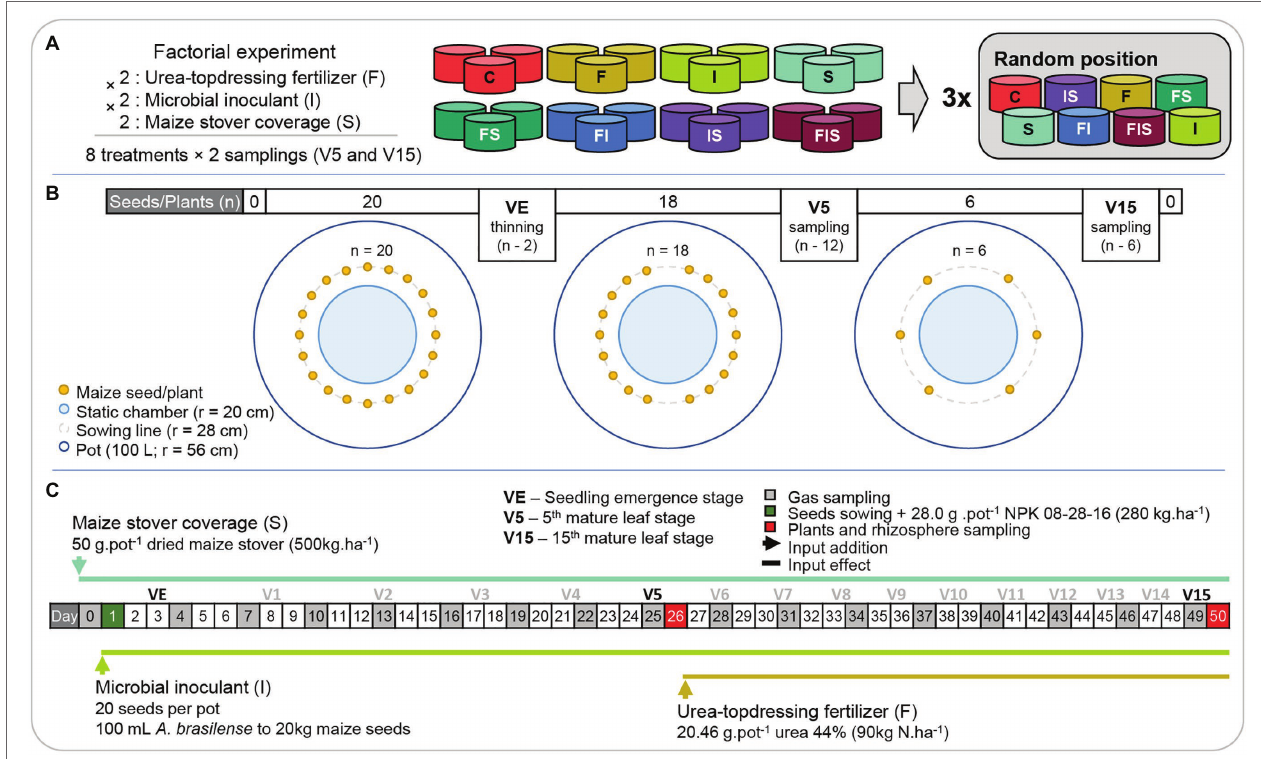
FIGURE 1 | Schemes of the (A) experimental design and (B) mesocosm pots through the (C) timeline. Treatments: C, Control; F, Urea-topdressing fertilization at V5; I, A. brasilense inoculant on seeds sowing; FI, F + I; S, Maize stover coverage; FS, F + S; IS, I + S; FIS, F + I +